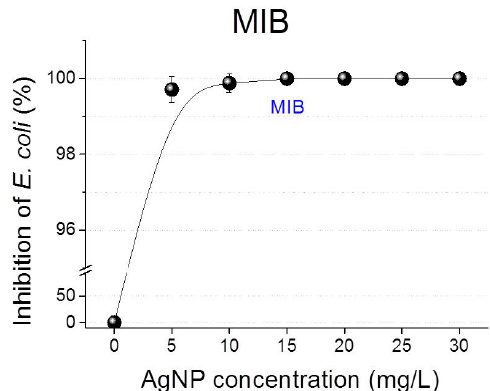
Fig. 7. CFU/mL E. coli ATCC 25992 and concentrations of AgNPs in MIB